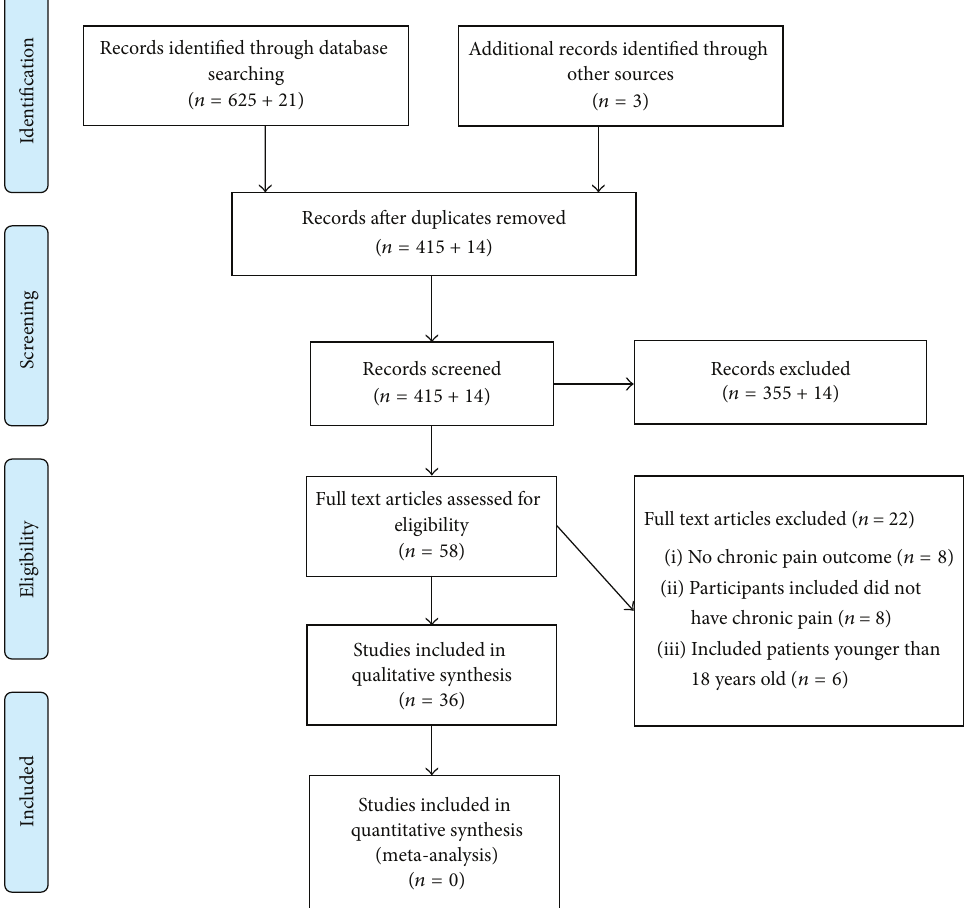
Figure 1: Diagram of the publications screening process based on PRISMA Statement (original search + search 6 months